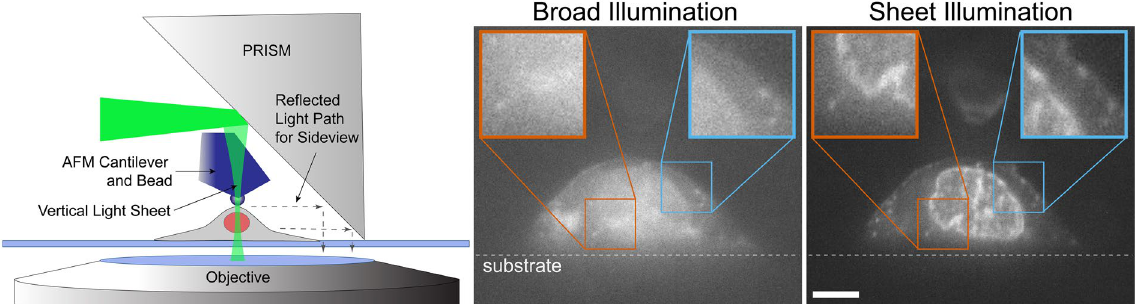
Figure 2. VLS enhanced PRISM imaging with AFM access. Left is a cartoon depiction of the experimental set up. The light sheet emerges from the imaging objective illuminating a vertical slice of the cell. A beaded AFM cantilever accesses the top of the cell for force measurements. A side-view image of the cell is reflected back into the objective, horizontally displaced from the plan-view image. The center and right panels show side-view images of an ovarian cancer cell labeled with membrane (Vybrant) and nucleic acid (SYTO83) dyes using broad and sheet illumination respectively. Images are taken with the same exposure time and plane of focus, and indicate a pronounced improvement in signal to noise with VLS illumination. Enlarged regions of interest show improved resolution of the nuclear boundary and cell membrane. Scale bar = 5